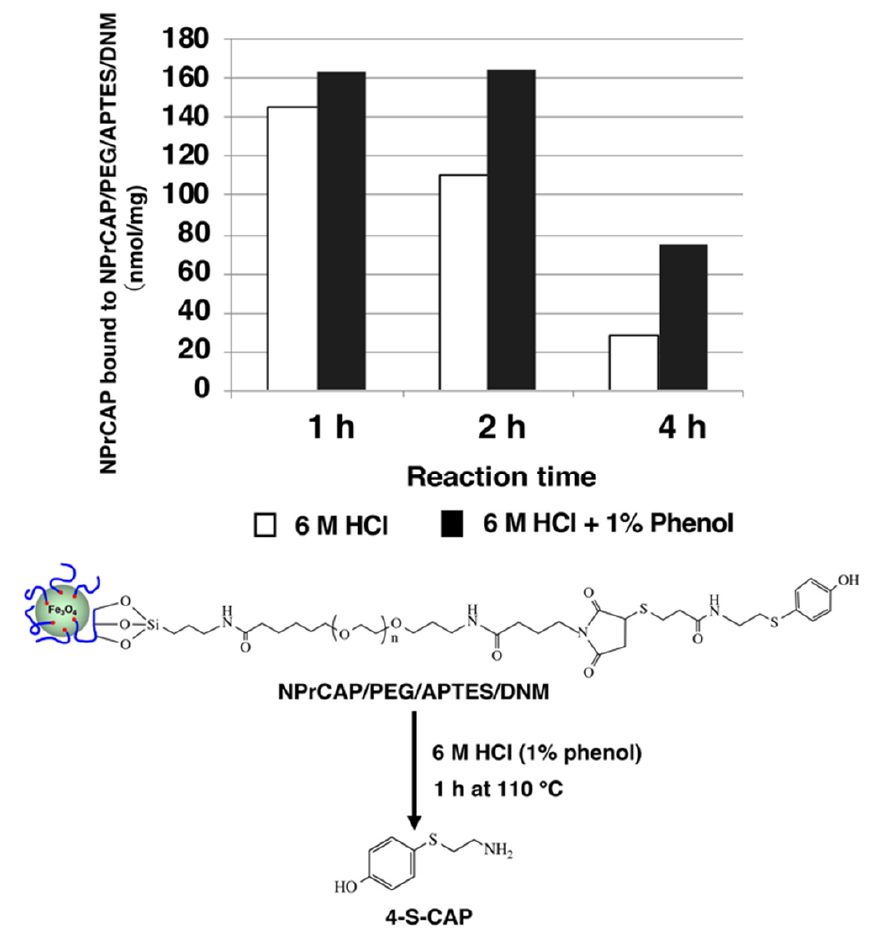
Figure 7. Quantification of NPrCAP bound to NPrCAP/PEG/APTES/DNM, and production of 4- S -CAP from NPrCAP/PEG/APTES/DNM by 6 M HCl containing 1% phenol.